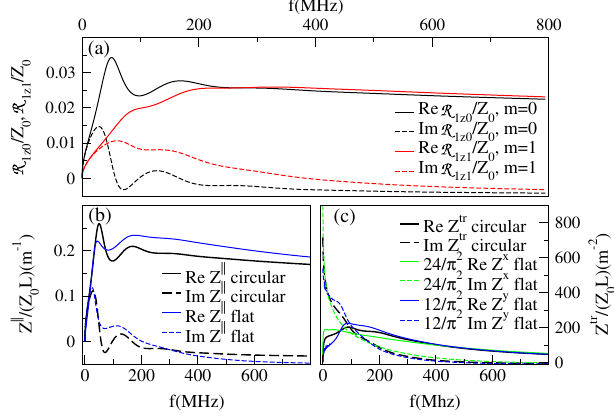
FIG. 6. The parameters for the round chamber with lamina- tions are the same as for our flat chamber example, b ¼ 2 : 1 cm , d ¼ 15 : 24 cm , ( m ¼ 0 , black) and R 1 (a) Crack surface impedance R 1 z 0 z 1 ( m ¼ 1 , red). At low frequency both cases display resistive-wall ffiffiffiffi p ! behavior proportional to . However, while the m ¼ 0 surface the m ¼ 1 one is impedance is proportional to a factor of ln d b proportional to a smaller factor of d 2 (cid:1) b 2 . (b) Longitudinal im- d 2 þ b 2 pedance ( m ¼ 0 ) for round chamber (black) and for flat chamber (blue). (c) Transverse impedance for round chamber (black) (green) and horizontal (vertical) impedance multiplied by 24 (cid:2) 2 [ 12 (blue)] for flat chamber. Note the significant differences (cid:2) 2 for frequencies smaller than 400 MHz.